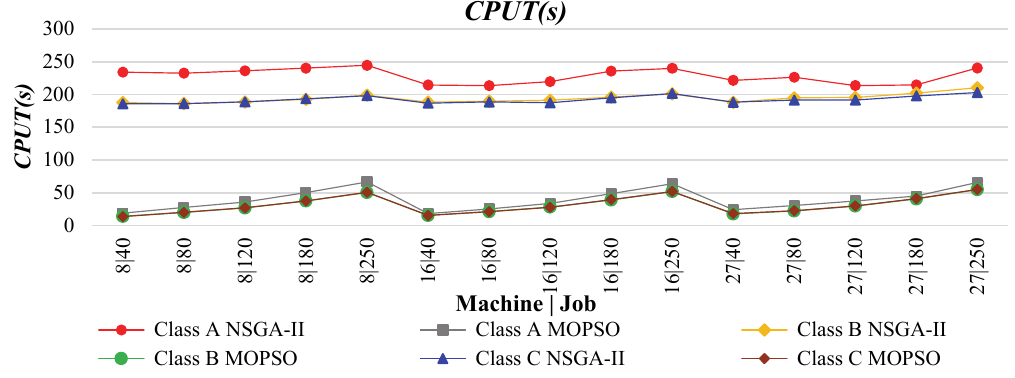
Fig. 20 CPUT criterion for the two algorithms in the medium and large scale sample problems